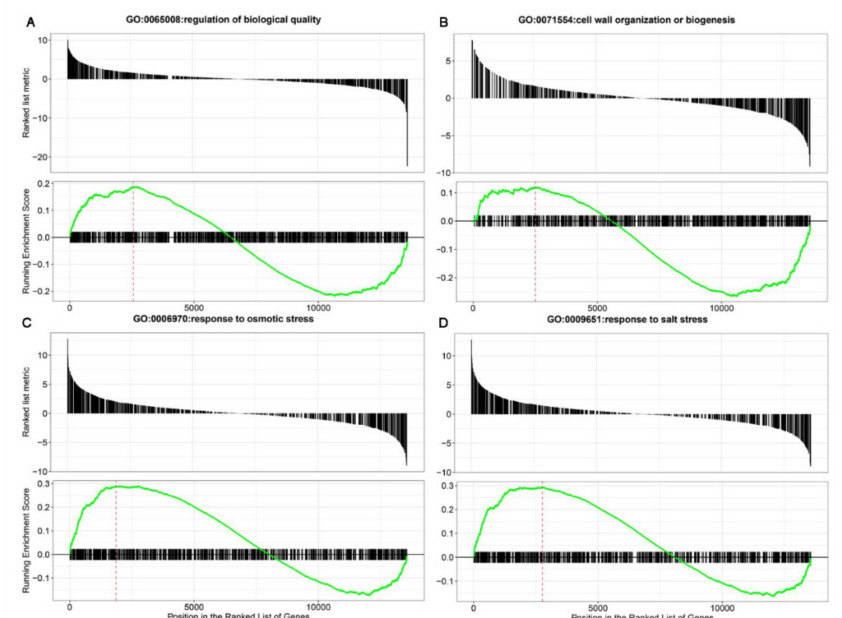
Figure 8. Gene set enrichment analysis (GSEA) analysis of differentially expressed genes (DEGs) expressed between the 0% and 50% calcification subtypes using the gene ontology (GO) datasets. ( A ) organization or biogenesis; ( B ) regulation of biological quality; ( C ) response to osmotic stress; ( D ) response to salt stress.